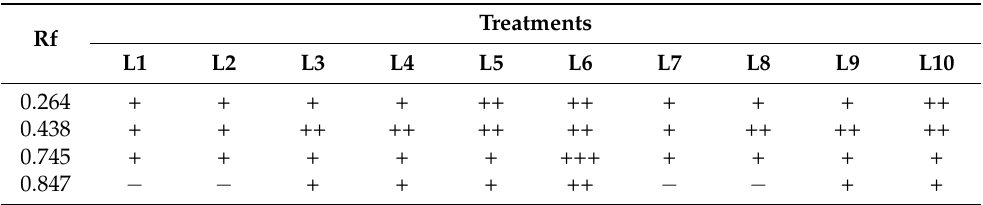
Figure 8. Effect of salinity (S) and foliar application of chitosan dissolved in different organic acids (Ch ACE, Ch ASC, Ch CIT and Ch MAL) and their interactions on ( A ) Polyphenol oxidase isozyme and ( B ) Ideogram analysis of polyphenol oxidase isozyme of tomato plants. Table 4. Isomers of polyphenol oxidase enzymes (+/ − ) and their Retention factor (Rf) in response Table. L1 = Control, L2 = Ch ACE, L3 = Ch ASC, L4 = Ch CIT, L5 = Ch MAL, L6 = S, L7 = S + Ch ACE, L8 = S + Ch ASC, L9 = S + Ch CIT and L10 = S + Ch MAL.